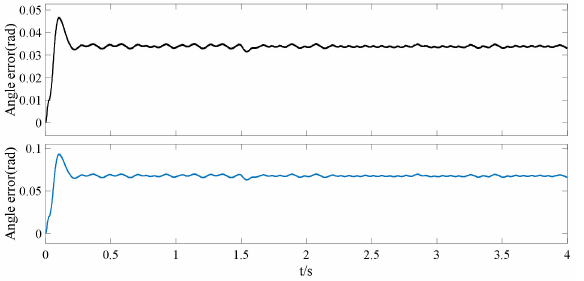
Figure 18. Waveform comparison of position angle error in the process of rotating speed change.